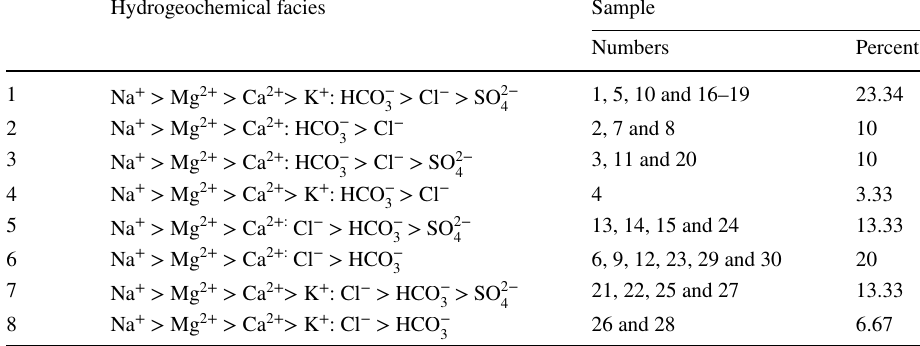
Hydrogeochemical facies